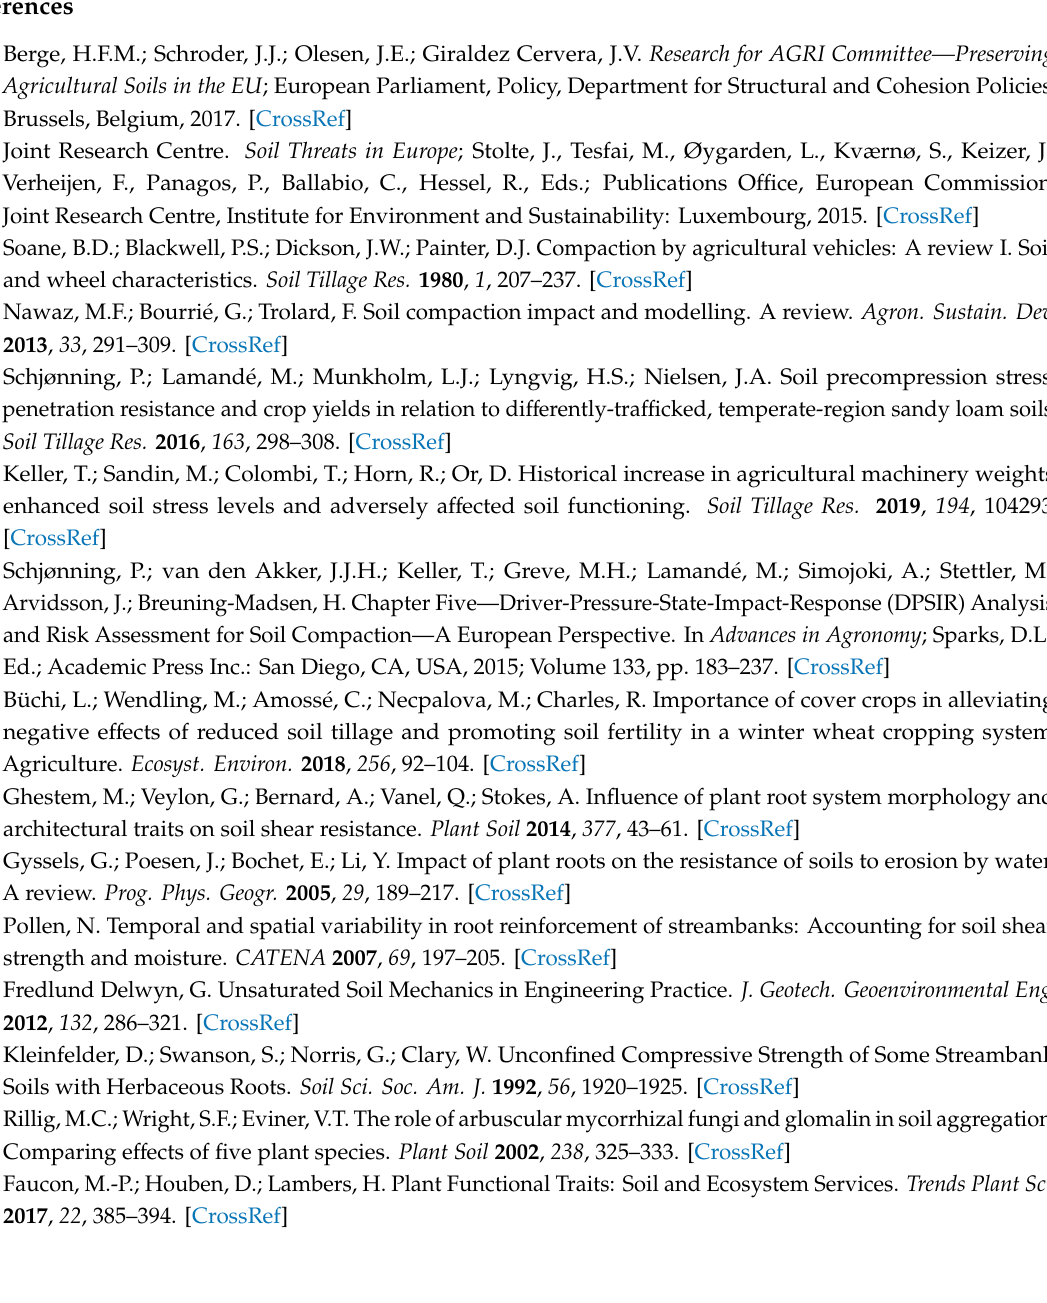
Figure S1: Climatic conditions between April and August 2018 at the experimental site, Table S1: Root traits and soil properties raw